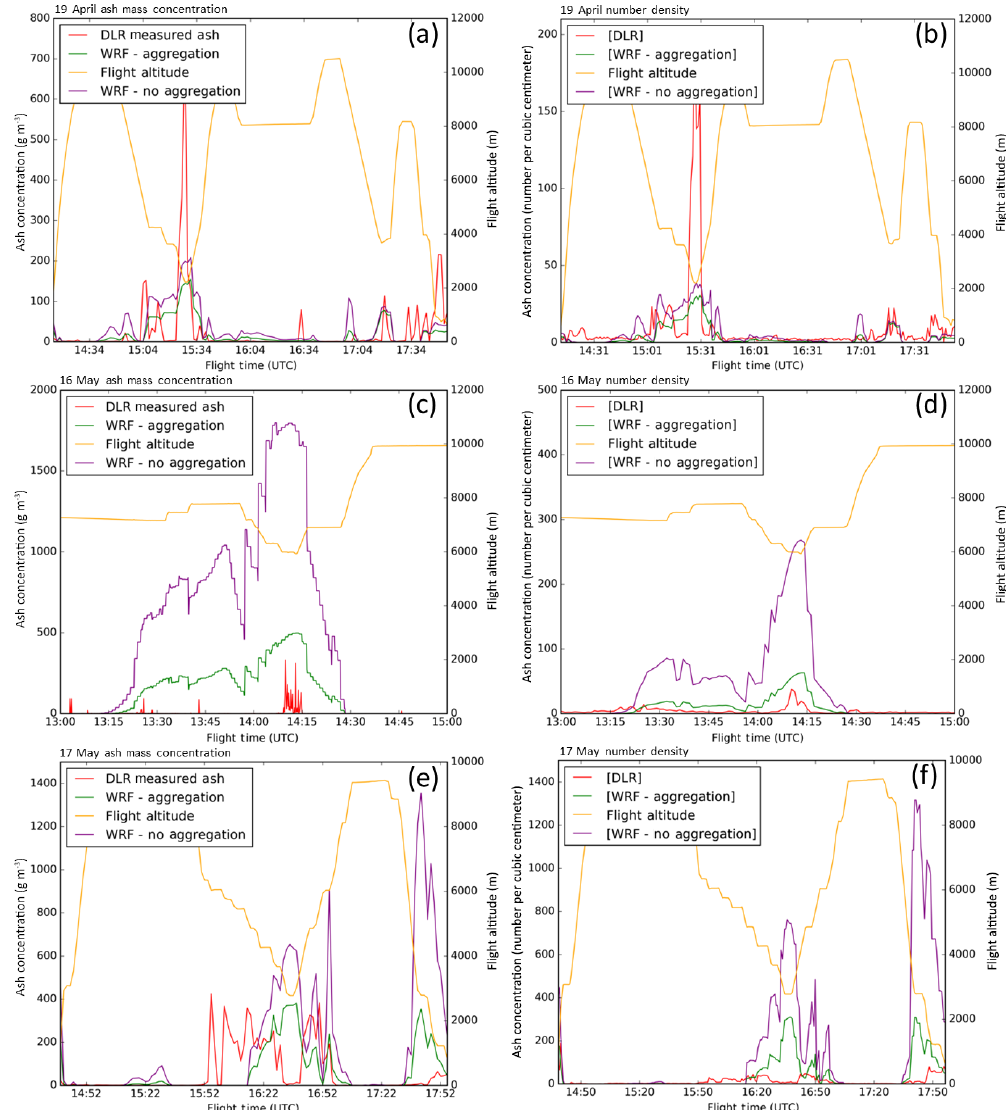
Figure 8. Comparisons of WRF-Chem model output to in situ mass concentrations (a, c, e) and particle numbers (b, d, f) observed by DLR during 19 April (a, b) , 15 May (c, d) , and 17 May (e, f) 2010